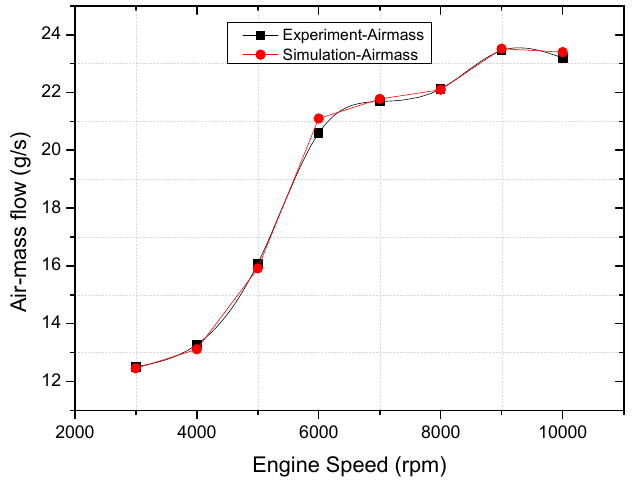
Figure 5. Air mass flow versus engine speed.